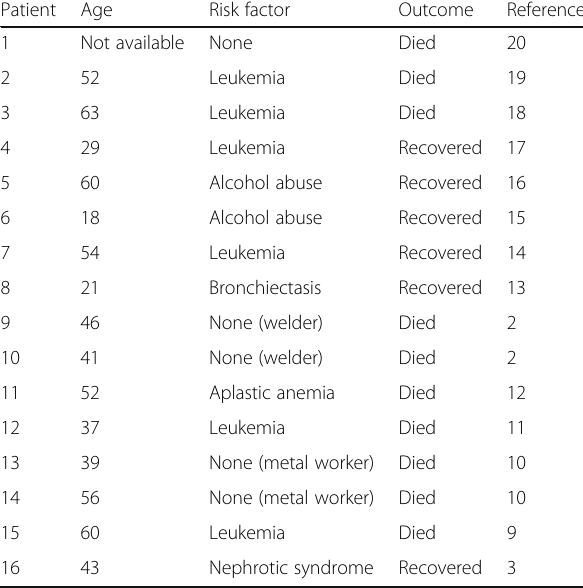
Table 1 Reported episodes of B. cereus pneumonia in